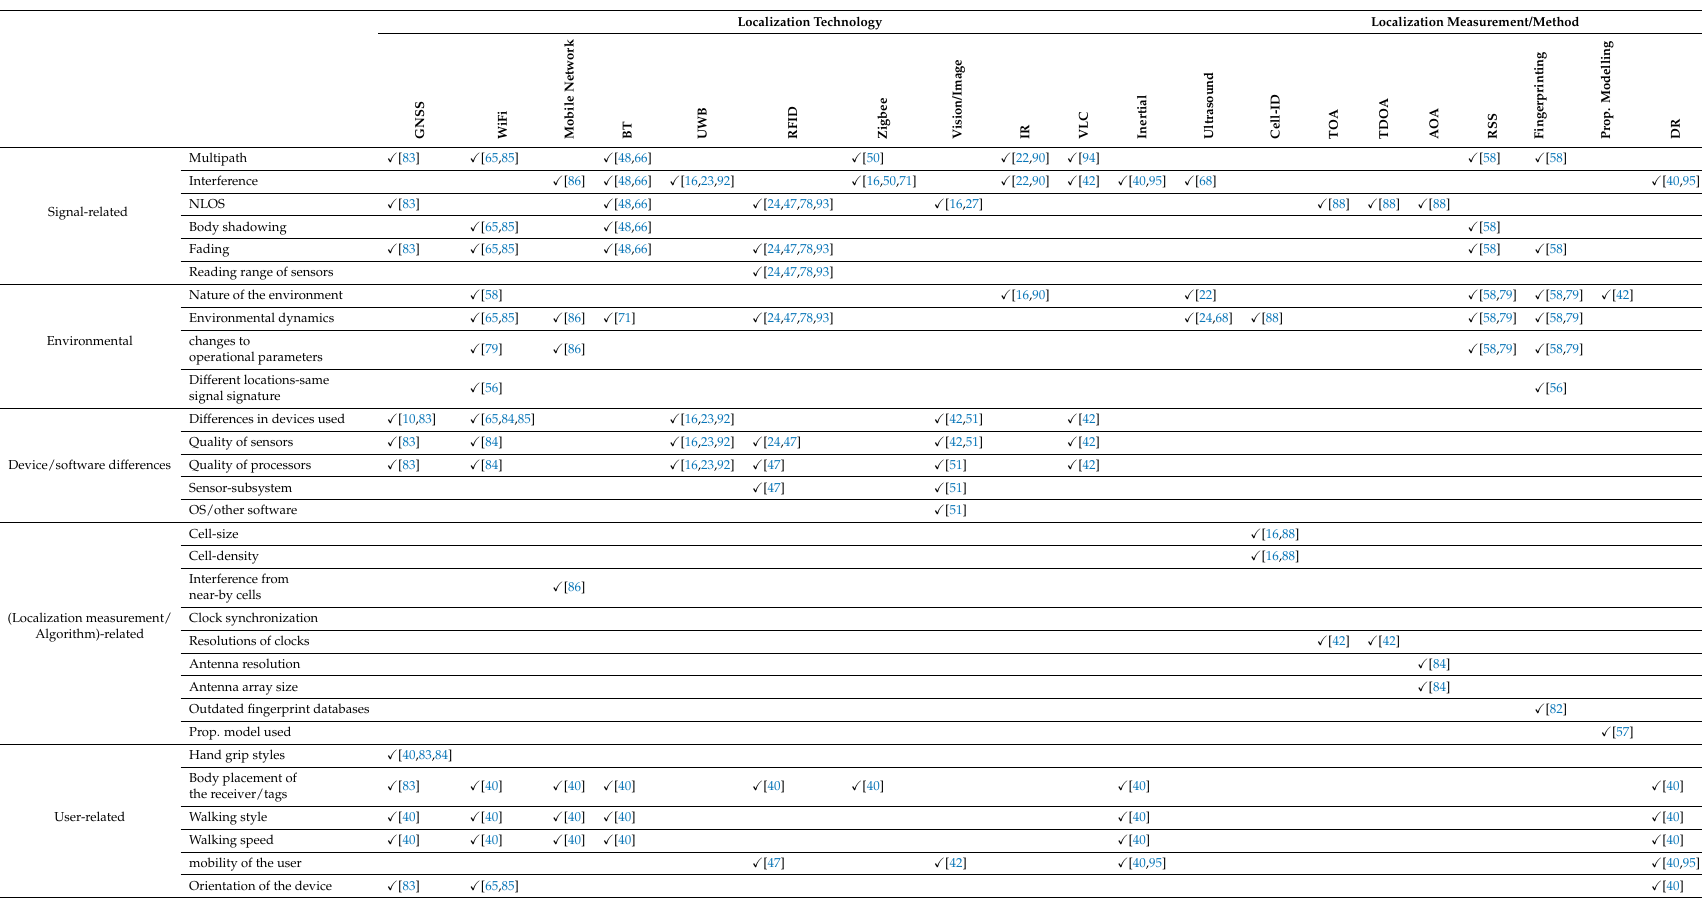
Table 2. Classification of factors that affect the quality of location